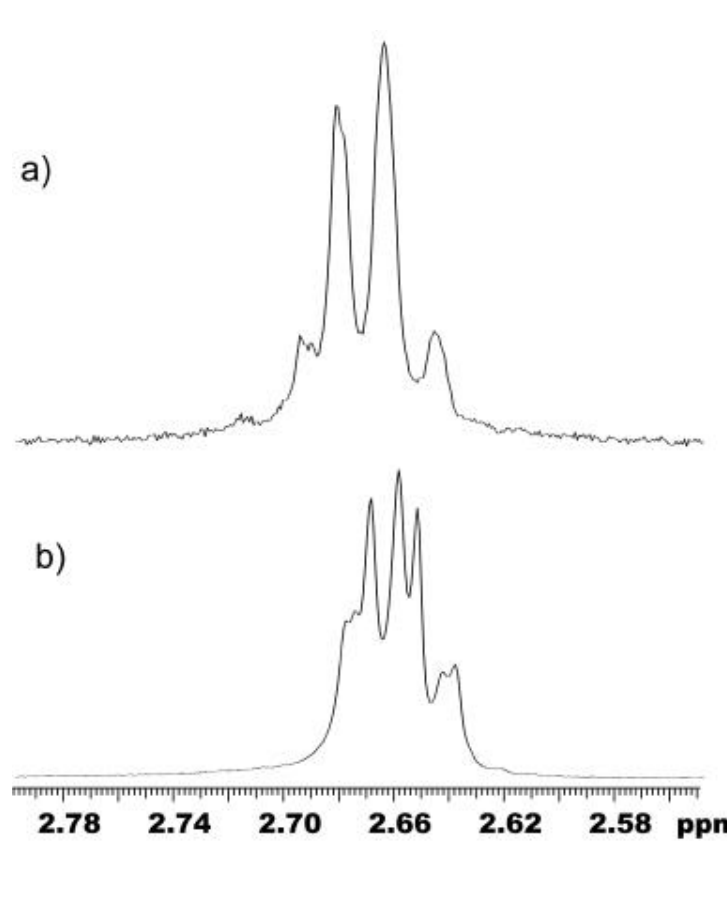
Figure 2 . a) An expanded region of the 1 H-NMR spectrum showing the bound dioxane signal of a standard reaction mixture of Me Q[ s,u ] dissolved in 0.2 M CsCl/D O; b) An expanded region of the 1 2 s 2